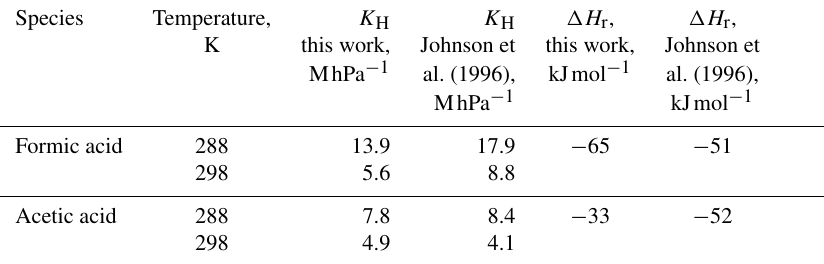
Table 4. Henry Law constants and enthalpies for formic and acetic acid. Species Temperature, K H K H (cid:49)H r , (cid:49)H r , K this work, Johnson et this work, Johnson et MhPa − 1 al. (1996), kJmol − 1 al. (1996), MhPa − 1 kJmol − 1 Formic acid 288 13.9